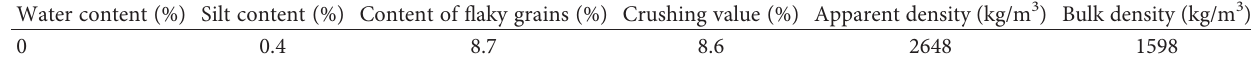
Table 3: Key technical indexes of gravels.